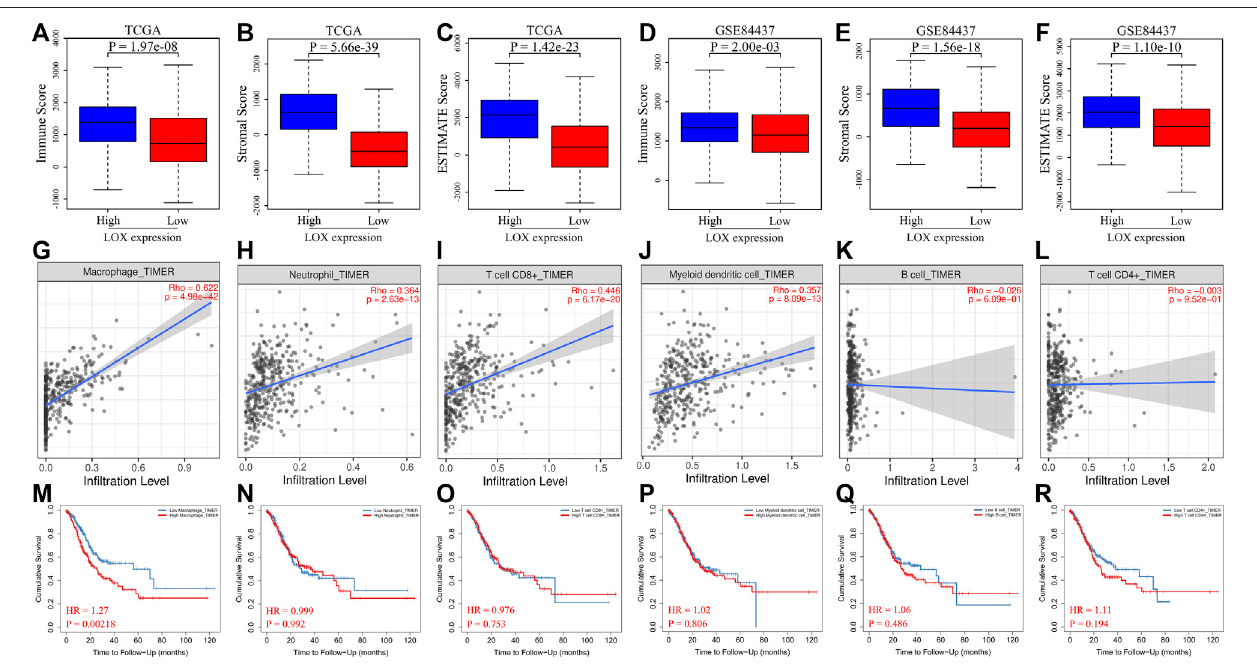
FIGURE 5 | The overexpression of LOX is related to immune cell in fi ltration of STAD. (A – C) Comparison of immune score (A) , stromal score (B) , and ESTIMATE score (C) between the high- and low-LOX-expression groups of STAD in TCGA database. (D – F) Comparison of immune score (D) , stromal score (E) , and ESTIMATE score (F) between the high- and low-LOX-expression groups of STAD in GSE84437 database. (G – L) The correlation between LOX expression and macrophages (G) , neutrophils (H) ,CD8 + Tcells (I) ,myeloiddendriticcells (J) ,Bcells (K) ,andCD4 + Tcells (L) ofgastriccancerinTIMERdatabase. (M – R) Theoverallsurvivalanalysis for macrophages (M) , neutrophils (N) , CD8 + T cells (O) , myeloid dendritic cells (P) , B cells (Q) , and CD4 + T cells (R) of gastric cancer in TIMER database.